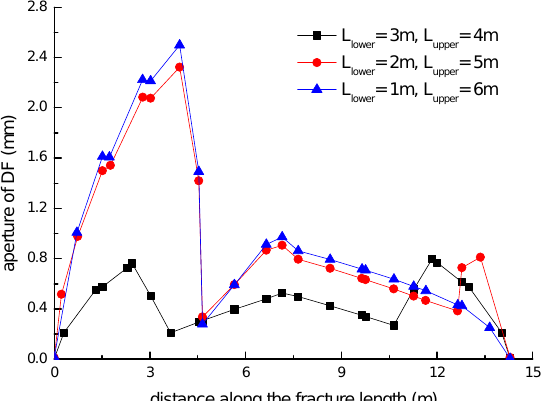
Figure 7. The fracture aperture curves of the DF along the fracture length at different lengths of the lower and upper parts of the NF. The distance in the x -axis is along the direction from the lower parts to the upper parts of the DF.